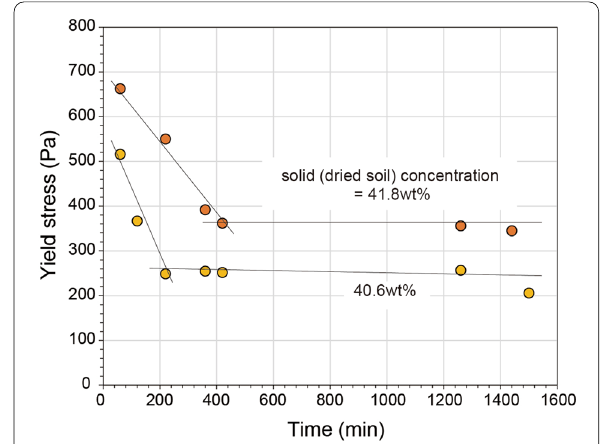
Fig. 4 Temporal evolution of yield stress for slurry of dried soil (solid concentrations of 41.8 and 40.6 wt%). The yield stress decreased rapidly in the first few hours and then remained